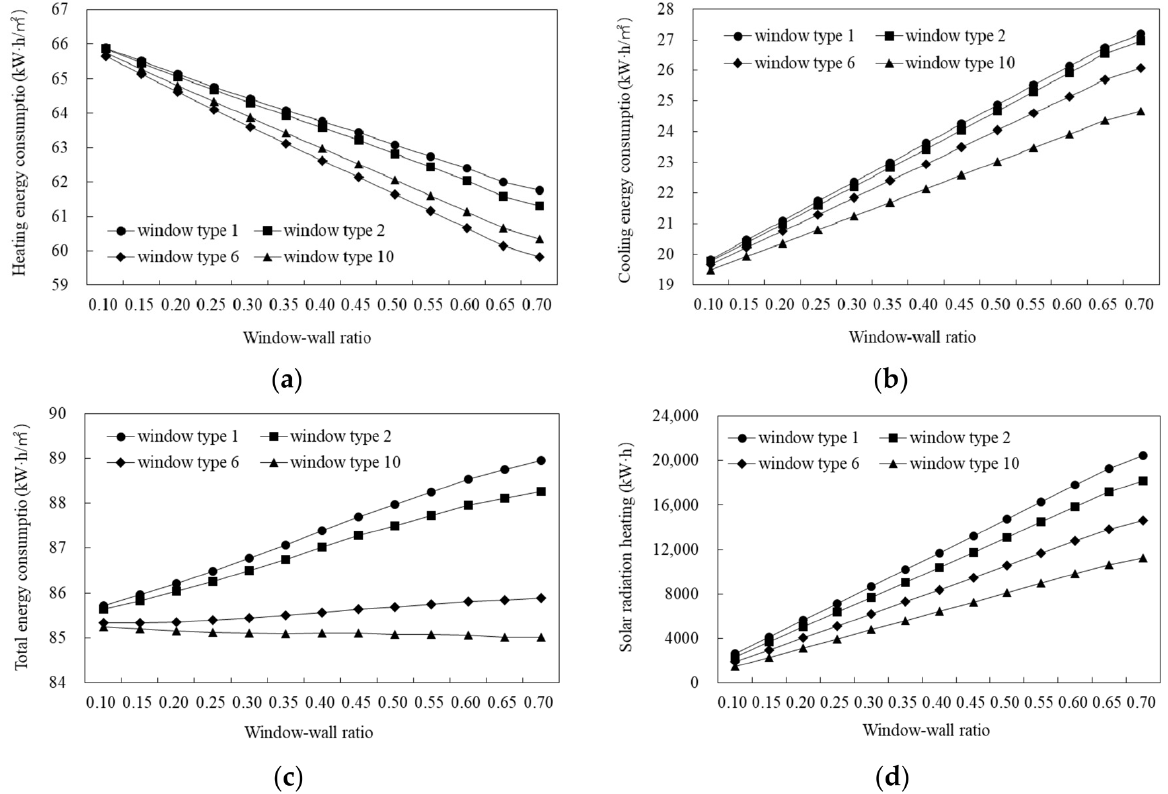
Figure 16. Relationships between south window–wall ratio and energy consumption and solar radiation heating: ( a ) heating energy consumption; ( b ) cooling energy consumption; ( c ) total energy consumption; ( d ) solar radiation